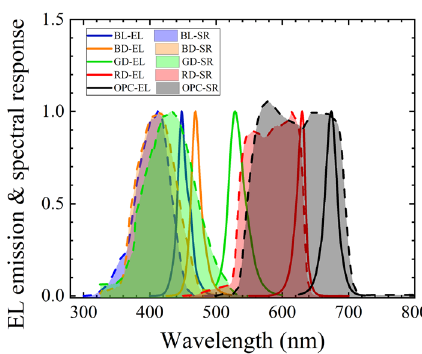
Figure 5. EL emissions and spectral responses for various types of emitters and detectors.